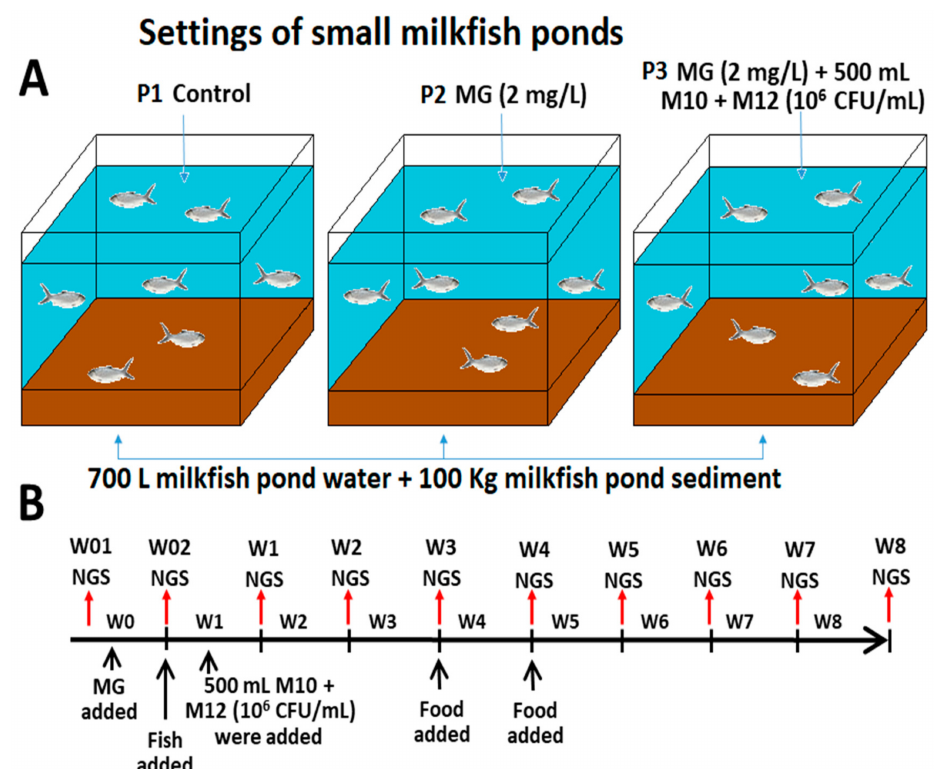
Figure 1. ( A ) Experimental setting of small milkfish ponds and timeline of sampling. ( B ) W0: the week before the addition of milkfish. W1–W8: the first to the 8th week after the start of the experiment. Red arrows indicate the times of water and sediment sampling. NGS indicates that the microbial communities in the samples were analyzed using next generation